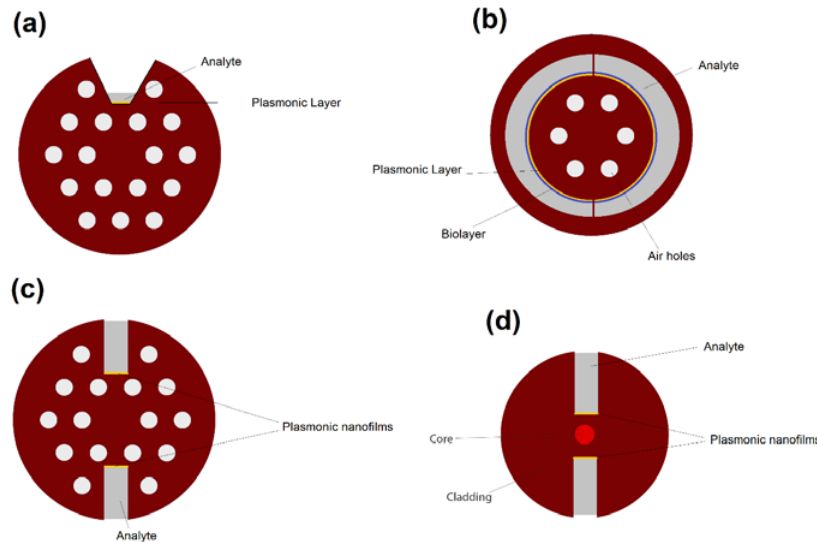
Figure 17. Cross section of PCF-based plasmonic biosensors based on a ( a ) trapezoidal-channel, ( b ) semi-circular channels, ( c ) H-shaped geometry with air holes, and ( d ) H-shaped microstructured geometry.